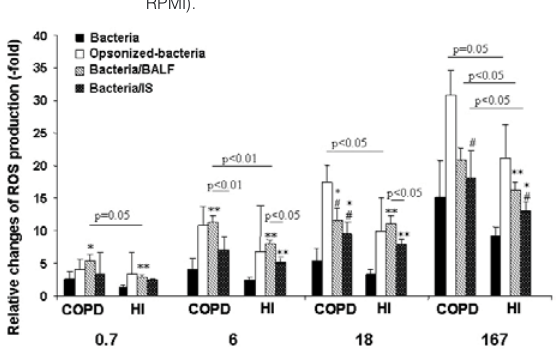
Data are shown as fold changes ±SEM. *p<0.05 compared to PMA alone. Figure 7. A histogram representing relative changes of ROS production in peripheral blood neutrophils of COPD patients and HI, after stimulation with IS in combination with different concentrations of PMA, according to basal